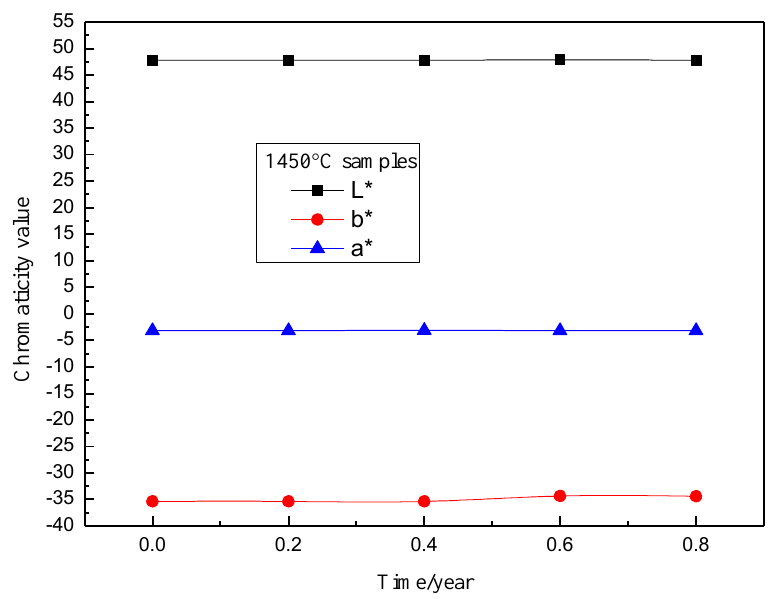
Figure 8. Chroma stability of samples with optimal doping amount at room temperature.